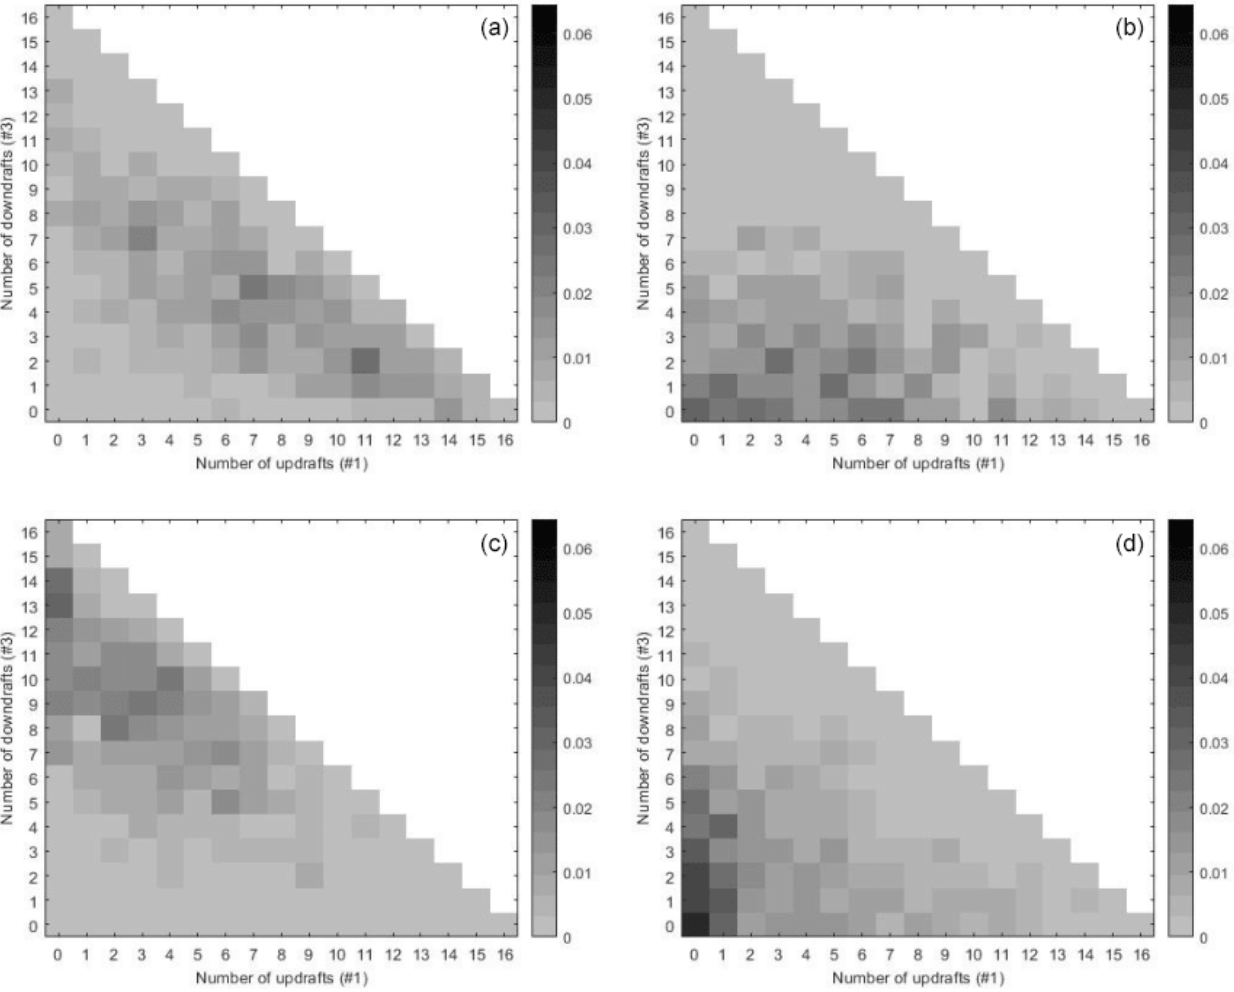
Figure 6. Histograms show probabilities of numbers of updrafts (#1) and downdrafts (#3) conditioned on high (a, b) and low (c, d) latent states. Panels (a) and (c) present day data and panels (b) and (d) the night data. CAPE and vertical velocity data correspond to the data applied in Fig.